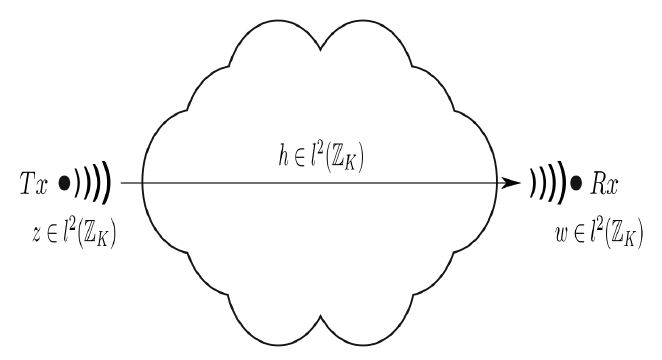
Figure 3. SISO input/output channel configuration.